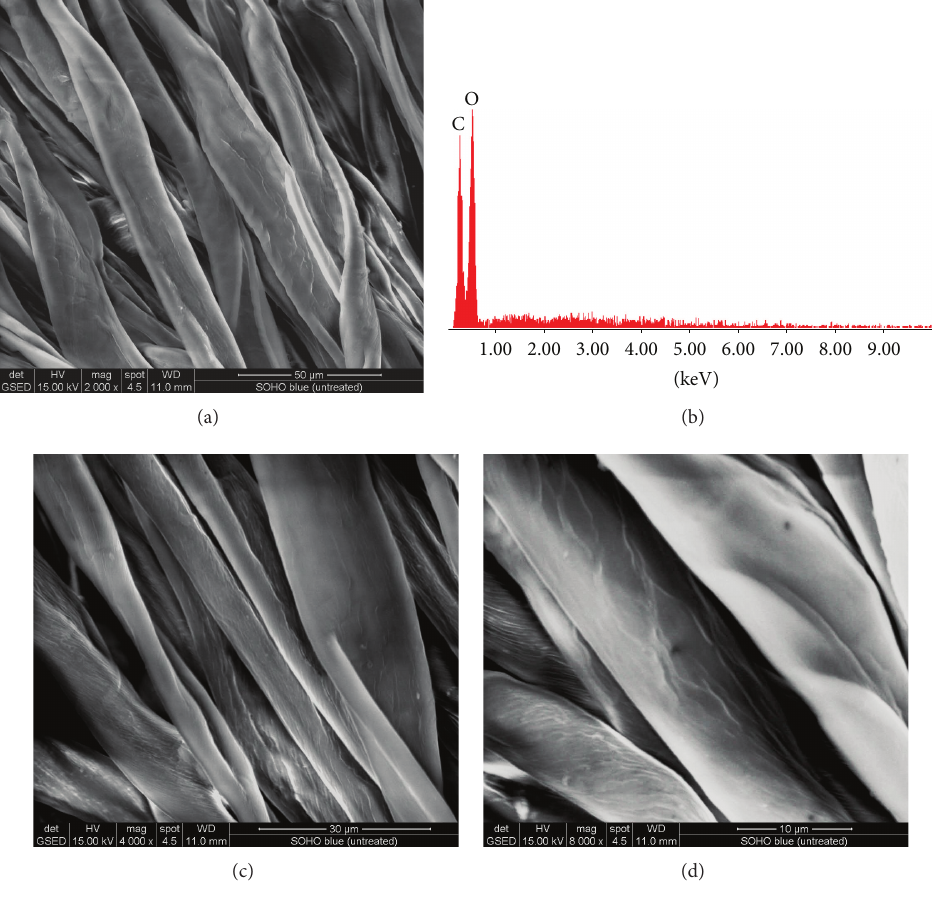
Figure 2: SEM and EDAX images for sample Ib (control) (plasma functionalized type I bleu cotton 100%): (a) SEM image for sample Ib at resolution × 2000, (b) EDAX image for sample Ib, (c) SEM image for sample Ib at resolution × 4000, and (d) SEM image for sample Ib at resolution ×